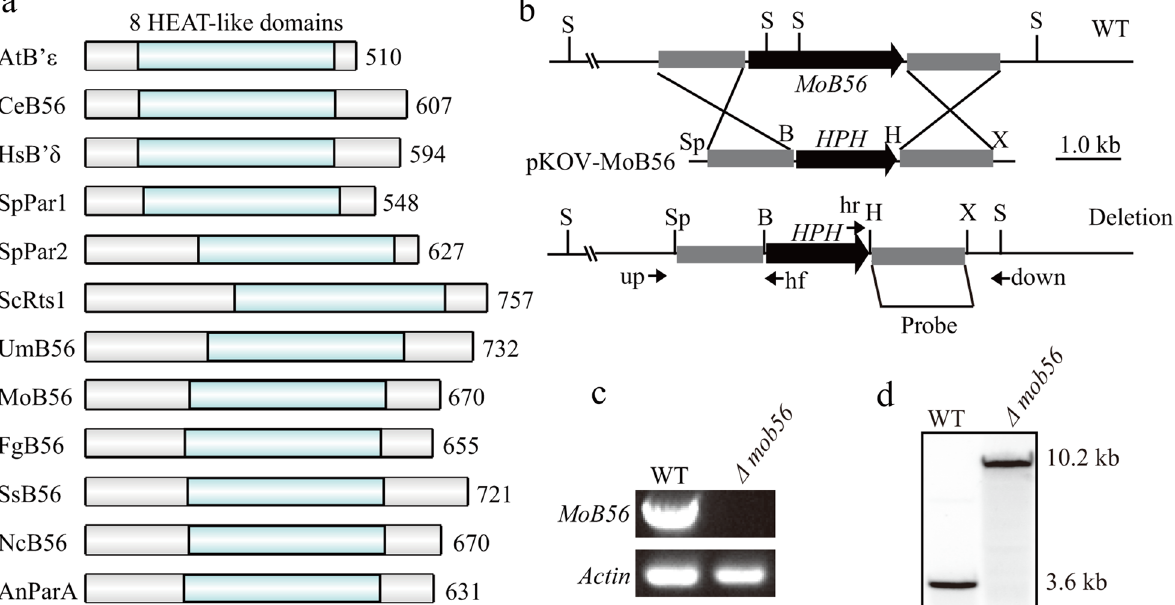
Fig. 1 Deletion of MoB56 in Magnaporthe oryzae . a Comparison of conserved domain diagrams among the regulatory B56 ortholog protein sequences in selected species. NCBI accession numbers are as follows: Arabidopsis thaliana epsilon isoform of B56, AtB’ε, NP_001030770.1; Caenorhabditis elegans CeB56, NP_001122845.1; delta isoform of B56 from Homo sapiens , HsB’δ, KAI2542369.1; Schizosaccharomyces pombe SpPar1, NP_588206.1; S. pombe SpPar2, NP_593298.1; Saccharomyces cerevisiae ScRts1, NP_014657.1; Ustilago maydis UmB56, XP_011389548.1; M.